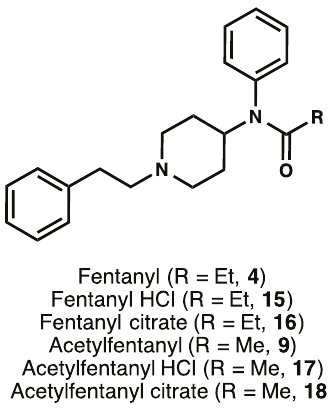
Figure 3. Fentanyl analogs synthesized in this work.